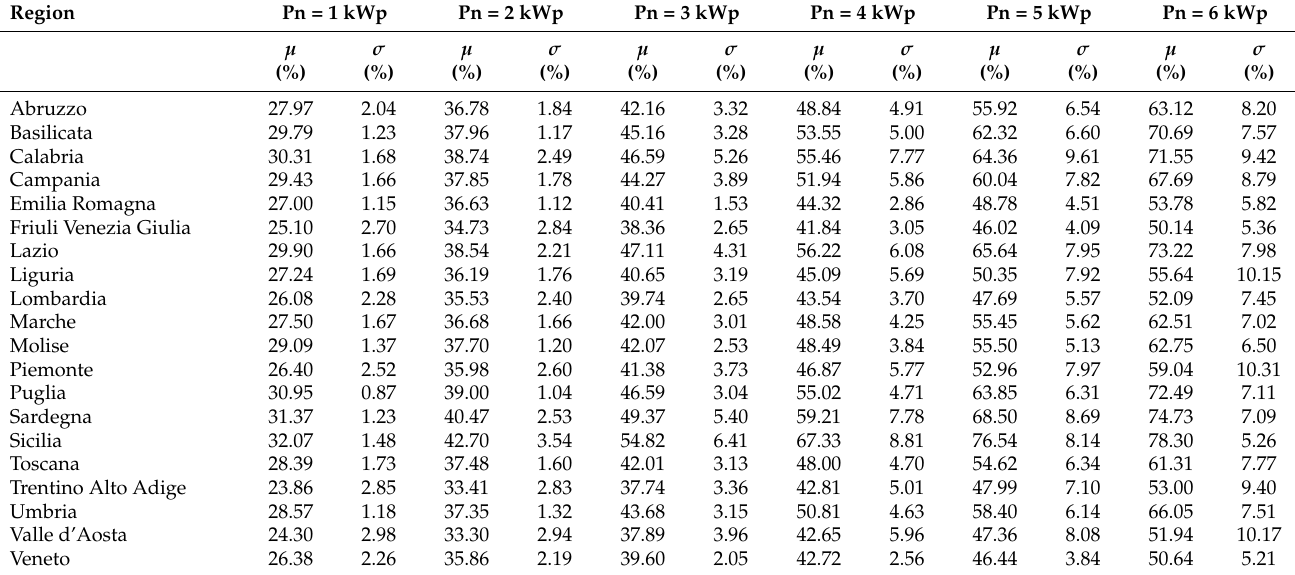
Table 25. Self-Sufficiency for E L = 4000 kWh with